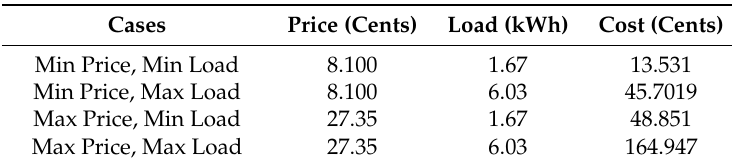
Table 12. Possible cases: OTI 60-min using RTP.